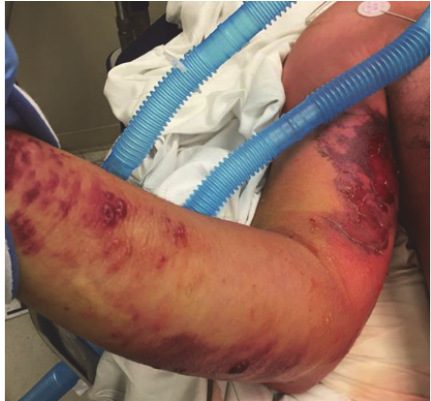
Figure 3: Right upper extremity progression prior to fasciotomy.